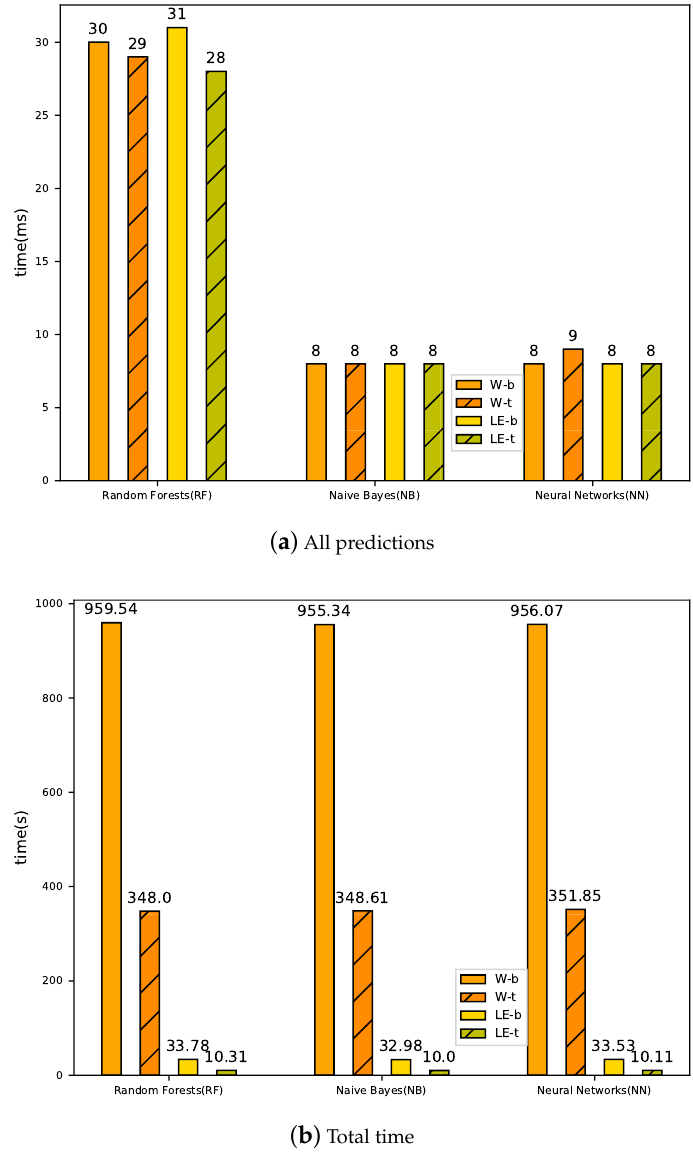
Figure 6. Computational time of training and testing with bary and tf-idf coordinate transformations. ( a ) computational time of issuing all predictions in test set; ( b ) total computational time. Figures 5 and 6 show the time consumed with tf-idf coordinate